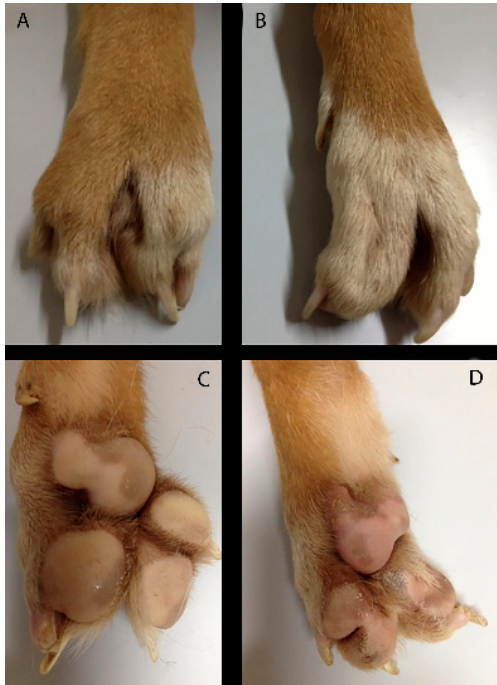
Figure 7. Case 3. Dorsal and Palmar views of both forelimbs. Right manus ( A , C ) and left manus ( B , D ).